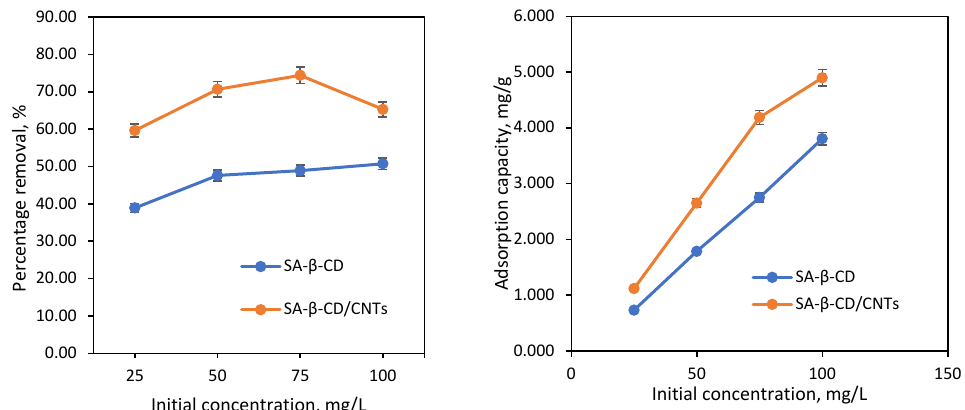
Figure 11. Effect of initial concentration. Condition: [dosage = 1000 mg, contact time = 120 min, pH = 5].